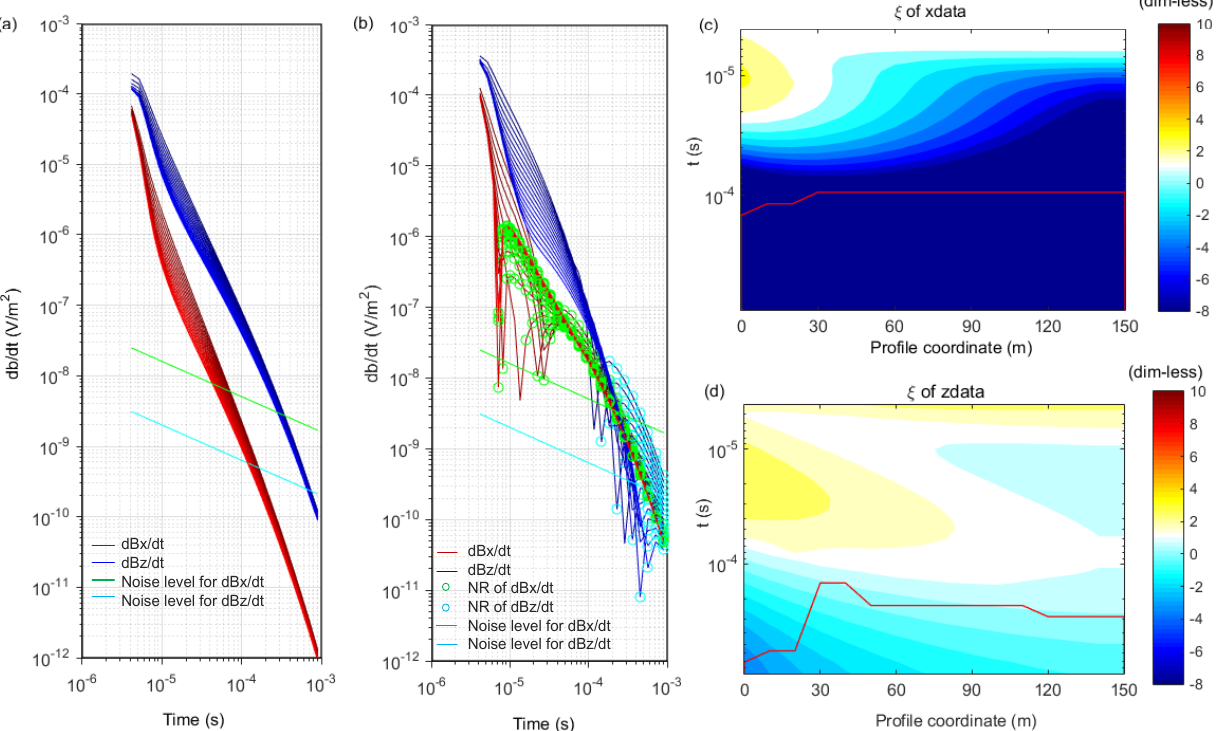
Figure 4. Results of forward modeling for the strong chargeable medium: ( a ) non-IP responses and ( b ) IP responses, where red curves represent d B x /d t , blue curves represent d B z /d t (the color becomes darker from W to E), and negative values are marked with green circles or cyan circles, respectively.